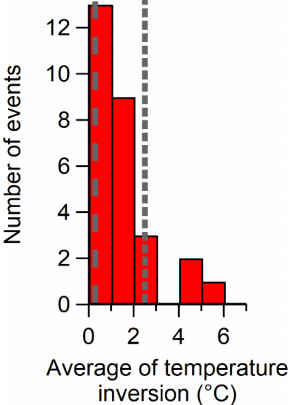
Figure 7. Histogram of the number of growth events near Eureka, binned by the average change in the temperature from 10 to 600m above sea level. The average temperature change of each event is provided in Table S1 and was calculated from radiosonde measure- ments during 2015 and 2016, as shown in Fig. 6. The dashed line in- dicates the average change in temperature during periods of low par- ticle concentrations as shown in Table S2 and Fig. S5 (0 . 3 ± 0 . 2 ◦ C), and the dotted line indicates the average change in temperature dur- ing periods with a persistent accumulation mode as shown in Ta- ble S2 and Fig. S6 (2 . 5 ± 1 . 2 ◦ C). The values in parentheses are the averages and their standard